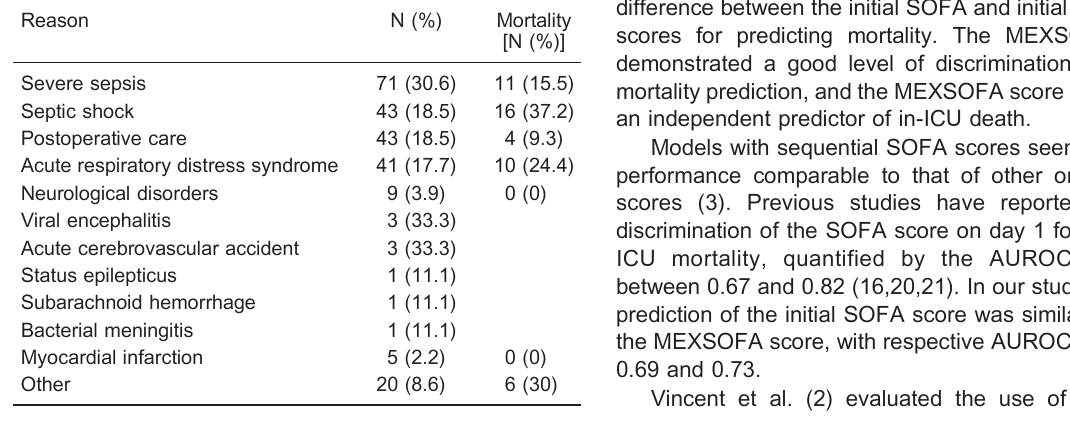
Table 4. Variables of the Mexican sequential organ failure assessment (MEXSOFA) on the day of admission to the intensive care unit (initial) according to outcome. Characteristics